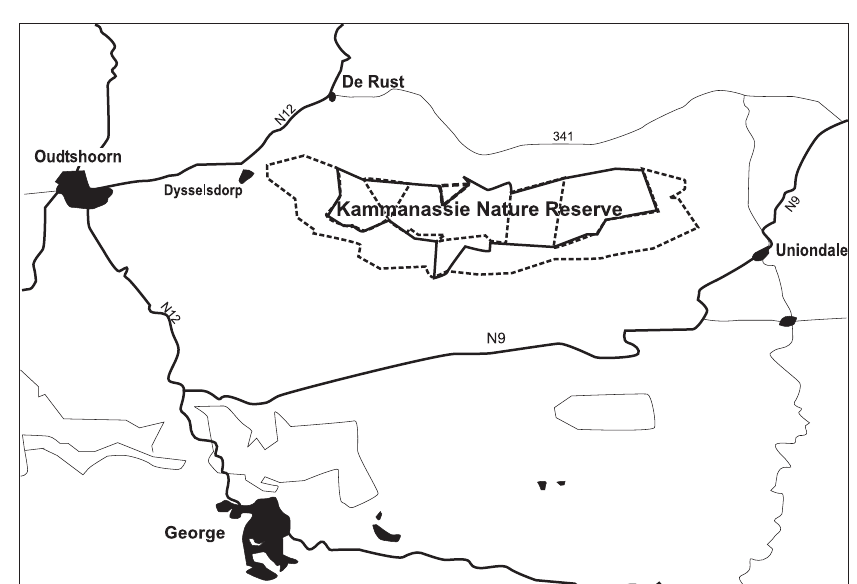
Fig. 1. Location of the study